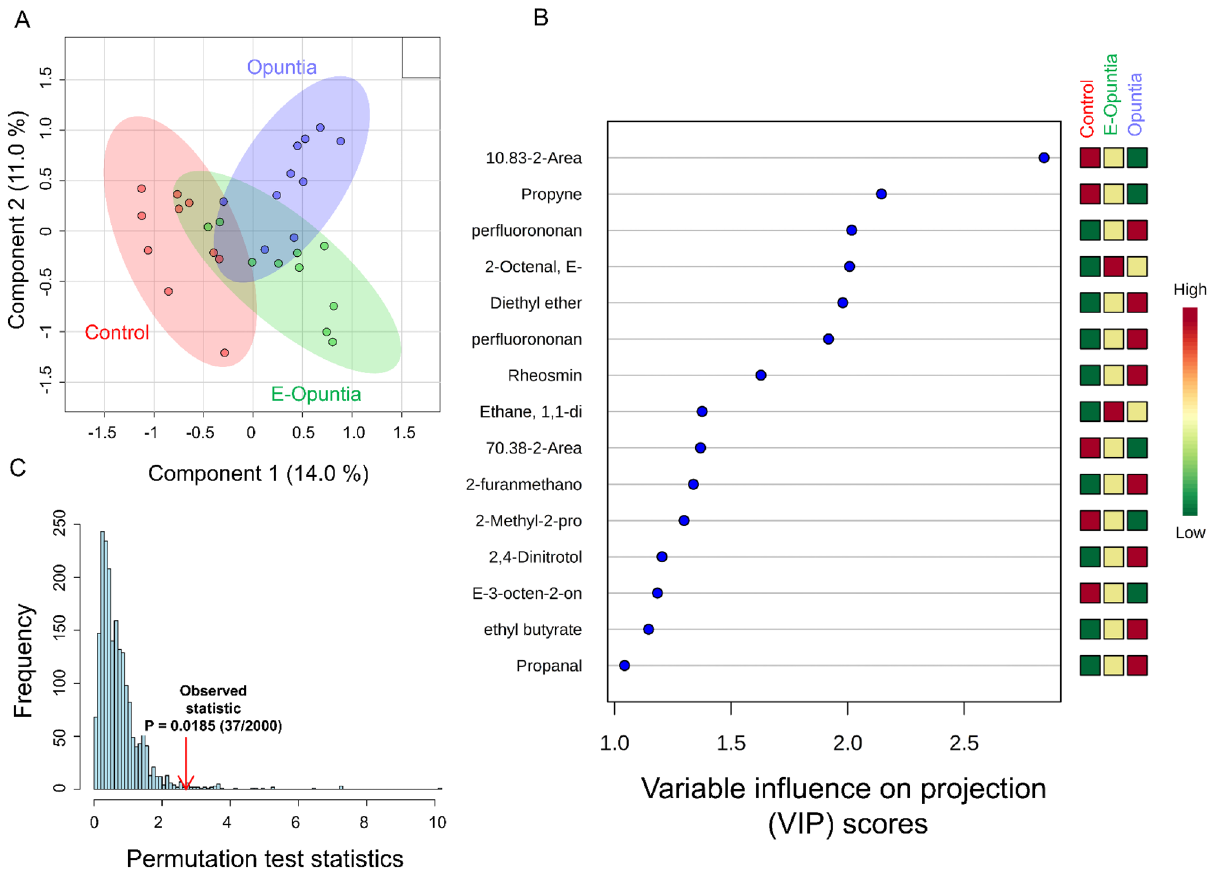
Figure 2. ( A ) Partial least squares-discriminant analysis (PLS-DA) showing 2 clusters for 3 treatments (Control, E-Opuntia, Opuntia); ( B ) the metabolites ranked by variable importance in projection (VIP) during dietary treatment (Day 30). ( C ) PLS-DA model validation by permutation tests based on separation distance of treatments. The p-value based on permutation was P = 0.0185 (37/2000). Metabolomics data analysis was performed using the free web-based metabolomics tool (MetaboAnalyst 4.0; https:// www. metab oanal yst. ca/ home. xhtml) 54